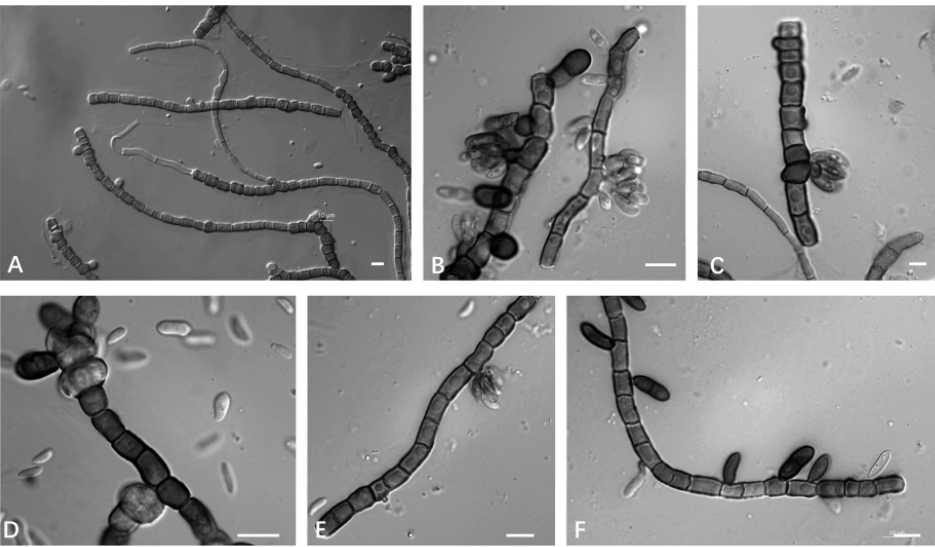
Figure 4. A. planticola (CGMCC 2.7199 ex-type culture). ( A – F ): Conidiogenous cells and thick-walled hyphae. Scale bar: ( A – F ) = 10 µm.